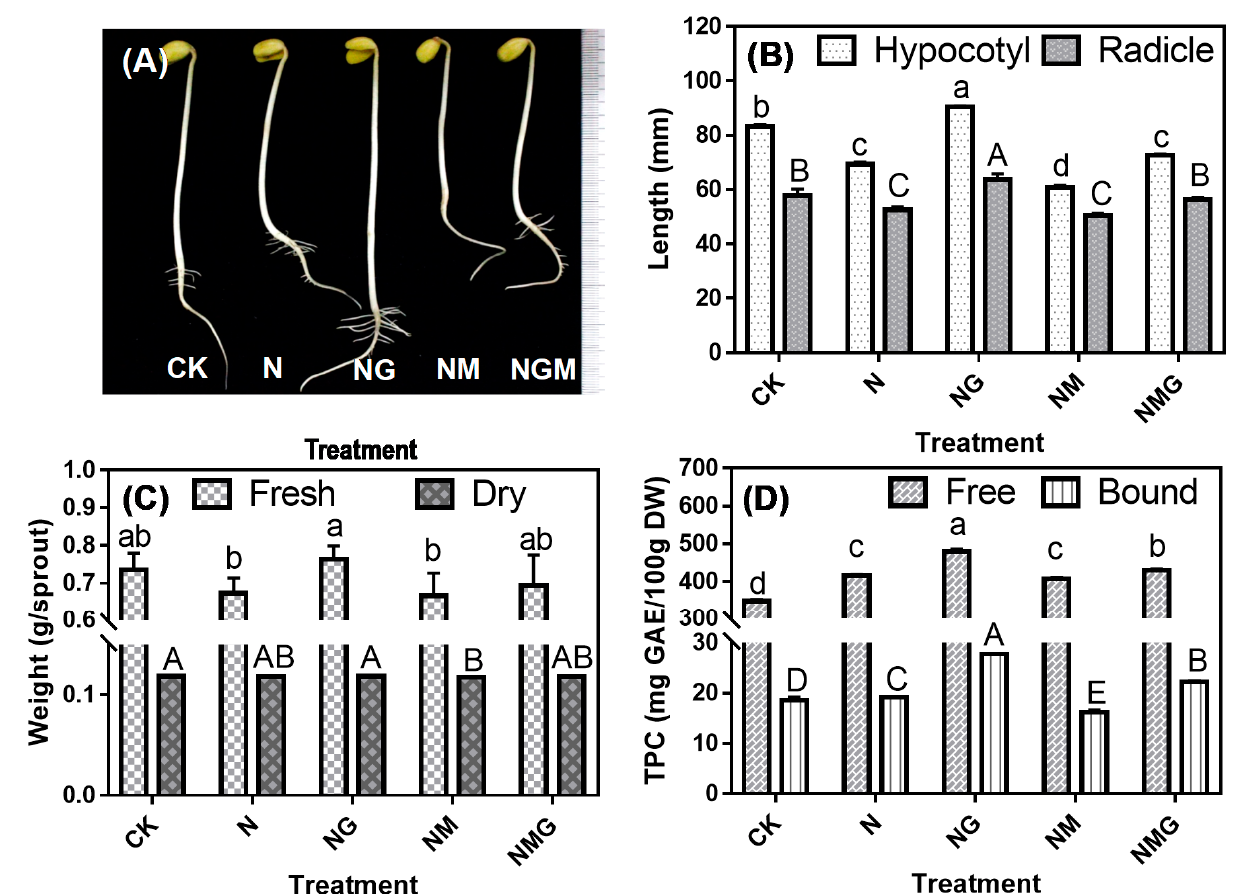
Figure 1. Effects of γ -aminobutyric acid (GABA) treatment on morphological status ( A ), length ( B ), weight ( C ), and phenolics content ( D ) of soybean sprouts under NaCl stress ( n = 3). CK indicates distilled water treatment, N indicates 40 mM NaCl treatment, NG indicates 40 mM NaCl + 5 mM GABA treatment, NM indicates 40 mM NaCl + 0.2 mM 3-MP treatment, and NGM indicates 40 mM NaCl + 0.2 mM 3-MP + 5 mM GABA treatment. Error bars represent the standard deviation. Values in the same measured category bearing different uppercase letters (A–E) or lowercase letters (a–d) are significantly different ( p <